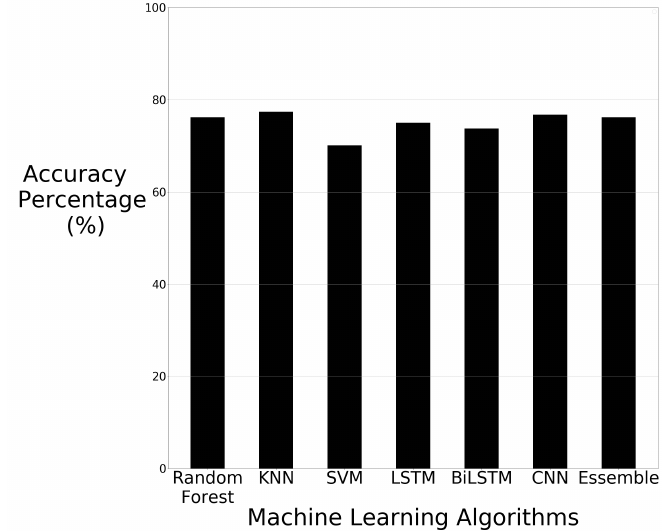
Figure 7. Machine learning results using raw image data with PCA.